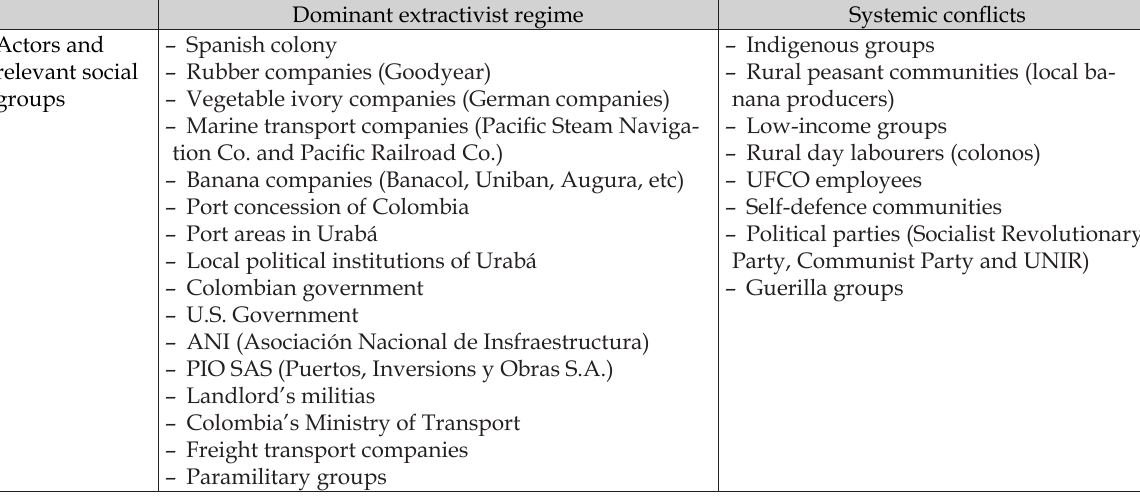
Table. 1. Agrarian extractivist actors, their techno-political frames and (in)justices. Dominant extractivist